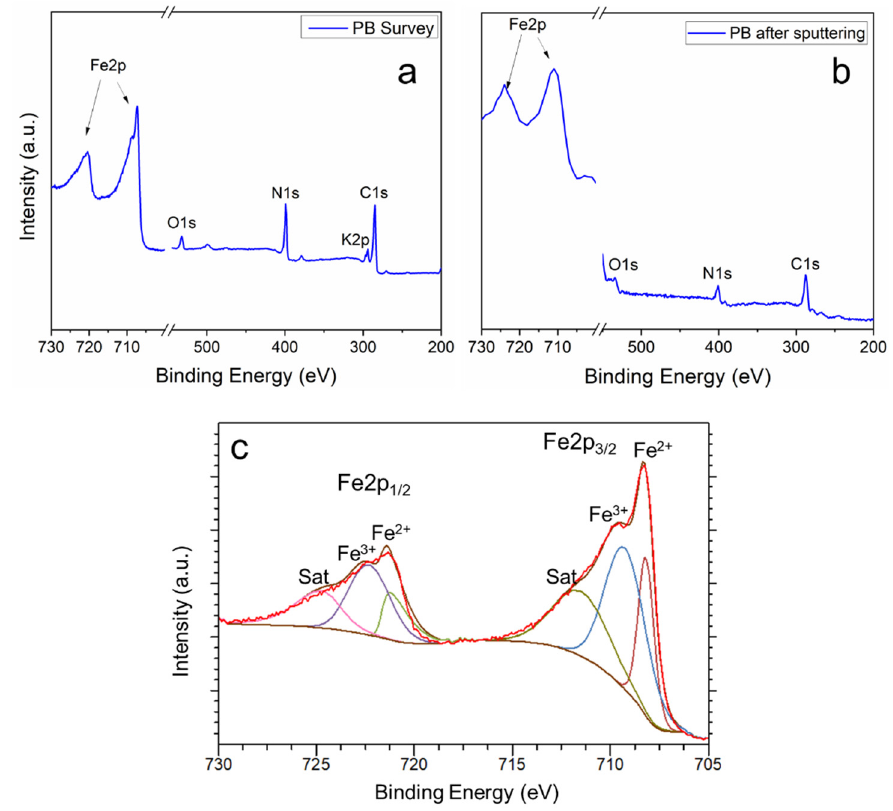
Figure 4. XPS spectra of PB films deposited at 0.3 V and 30 mC of charge: ( a ) survey spectrum of the as-grown film, ( b ) survey spectrum after Ar-ion-sputtering of 20 nm from the surface, ( c ) core level spectrum of Fe 2p measured from the as-grown film.